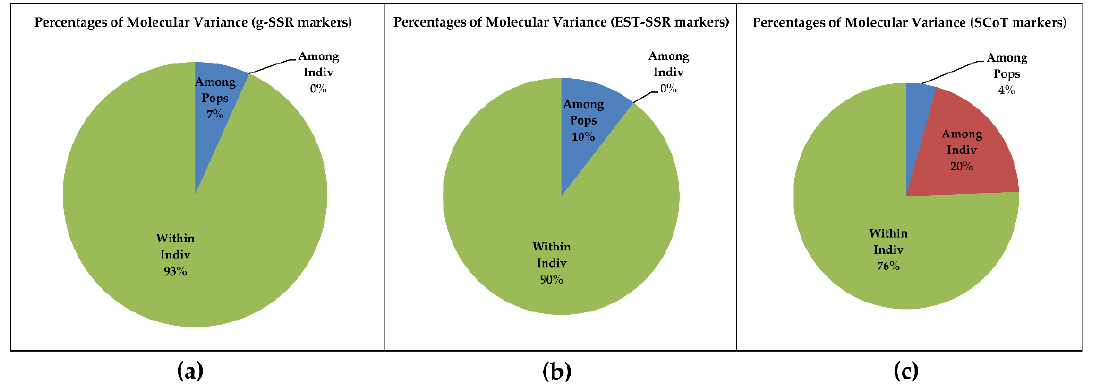
Figure 4. Analysis of Molecular variance (AMOVA) of 28 accessions of Tinospora based on ( a ) g-SSR ( b ) EST-SSR ( c ) SCoT markers.